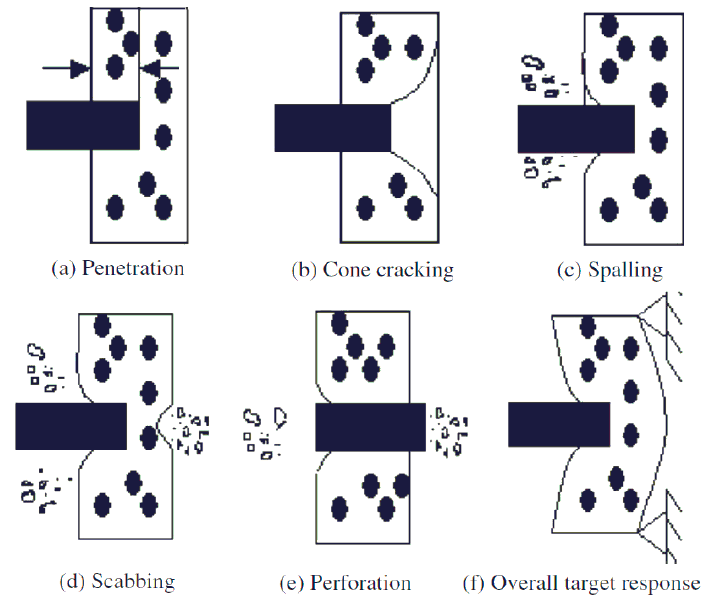
Figure 6. Identification of possible failure modes [15] into concrete target: ( a ) penetration into the target; ( b ) cone cracking and plugging due to the inertial stress wave; ( c ) spalling with the ejection of target material from the proximal face of the target; ( d ) radial cracking behind the initial wave front; ( e ) scabbing with the ejection of fragments from the distal face of the target; ( f ) potentially, perforation completely through the target;